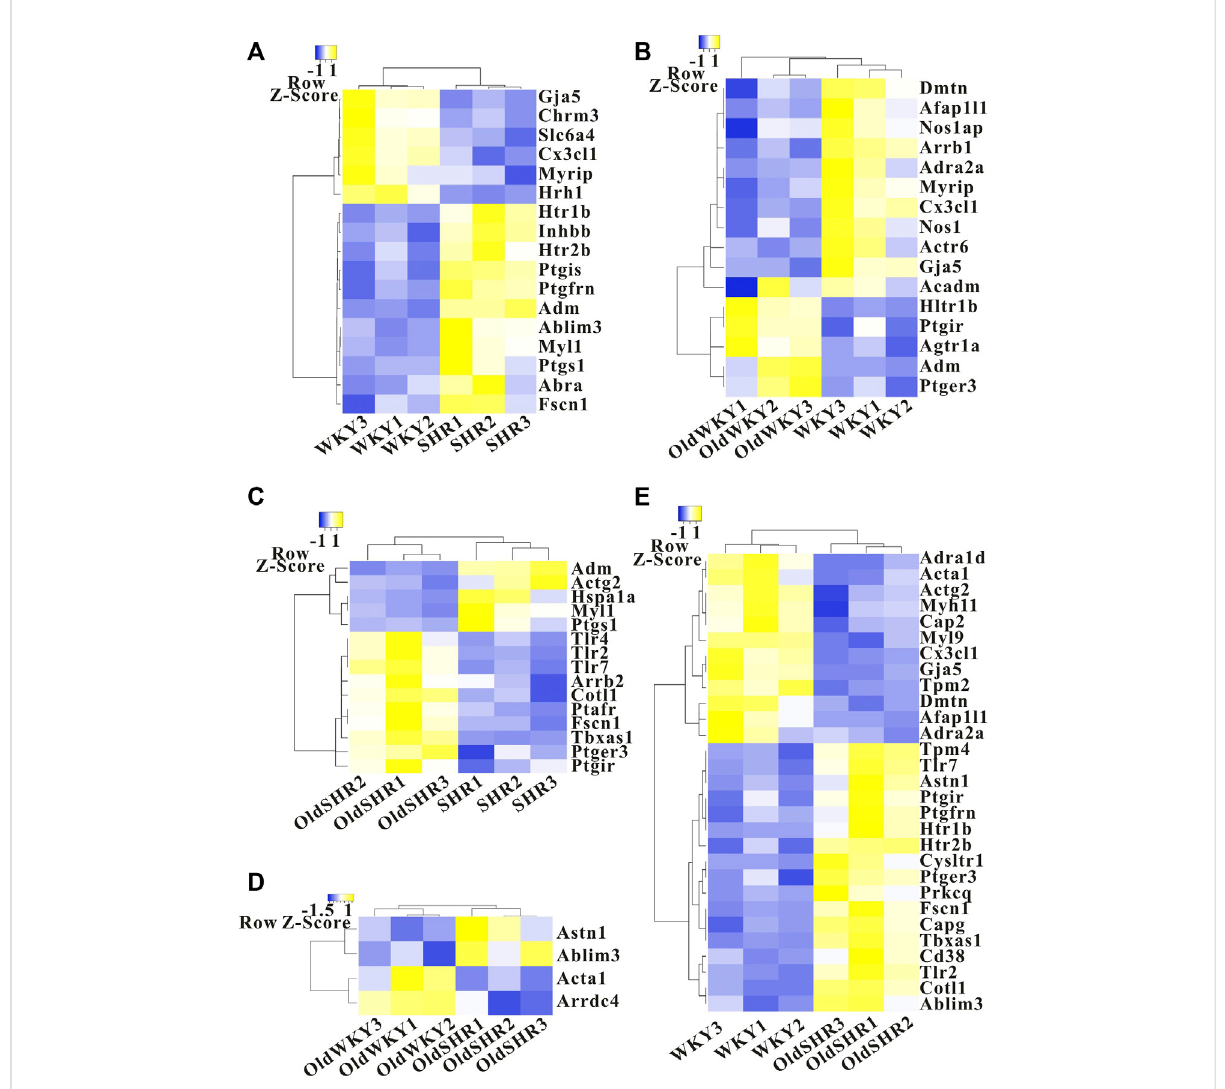
FIGURE 4 Heatmap showing differentially expressed genes in the TXA2-TP signaling pathway. (A) The SHR group was compared with the WKY group. (B) The OldWKY group was compared with the WKY group. (C) The OldSHR group was compared with the SHR group. (D) The OldSHR group was compared with the OldWKY group. (E) The OldSHR group was compared with the WKY